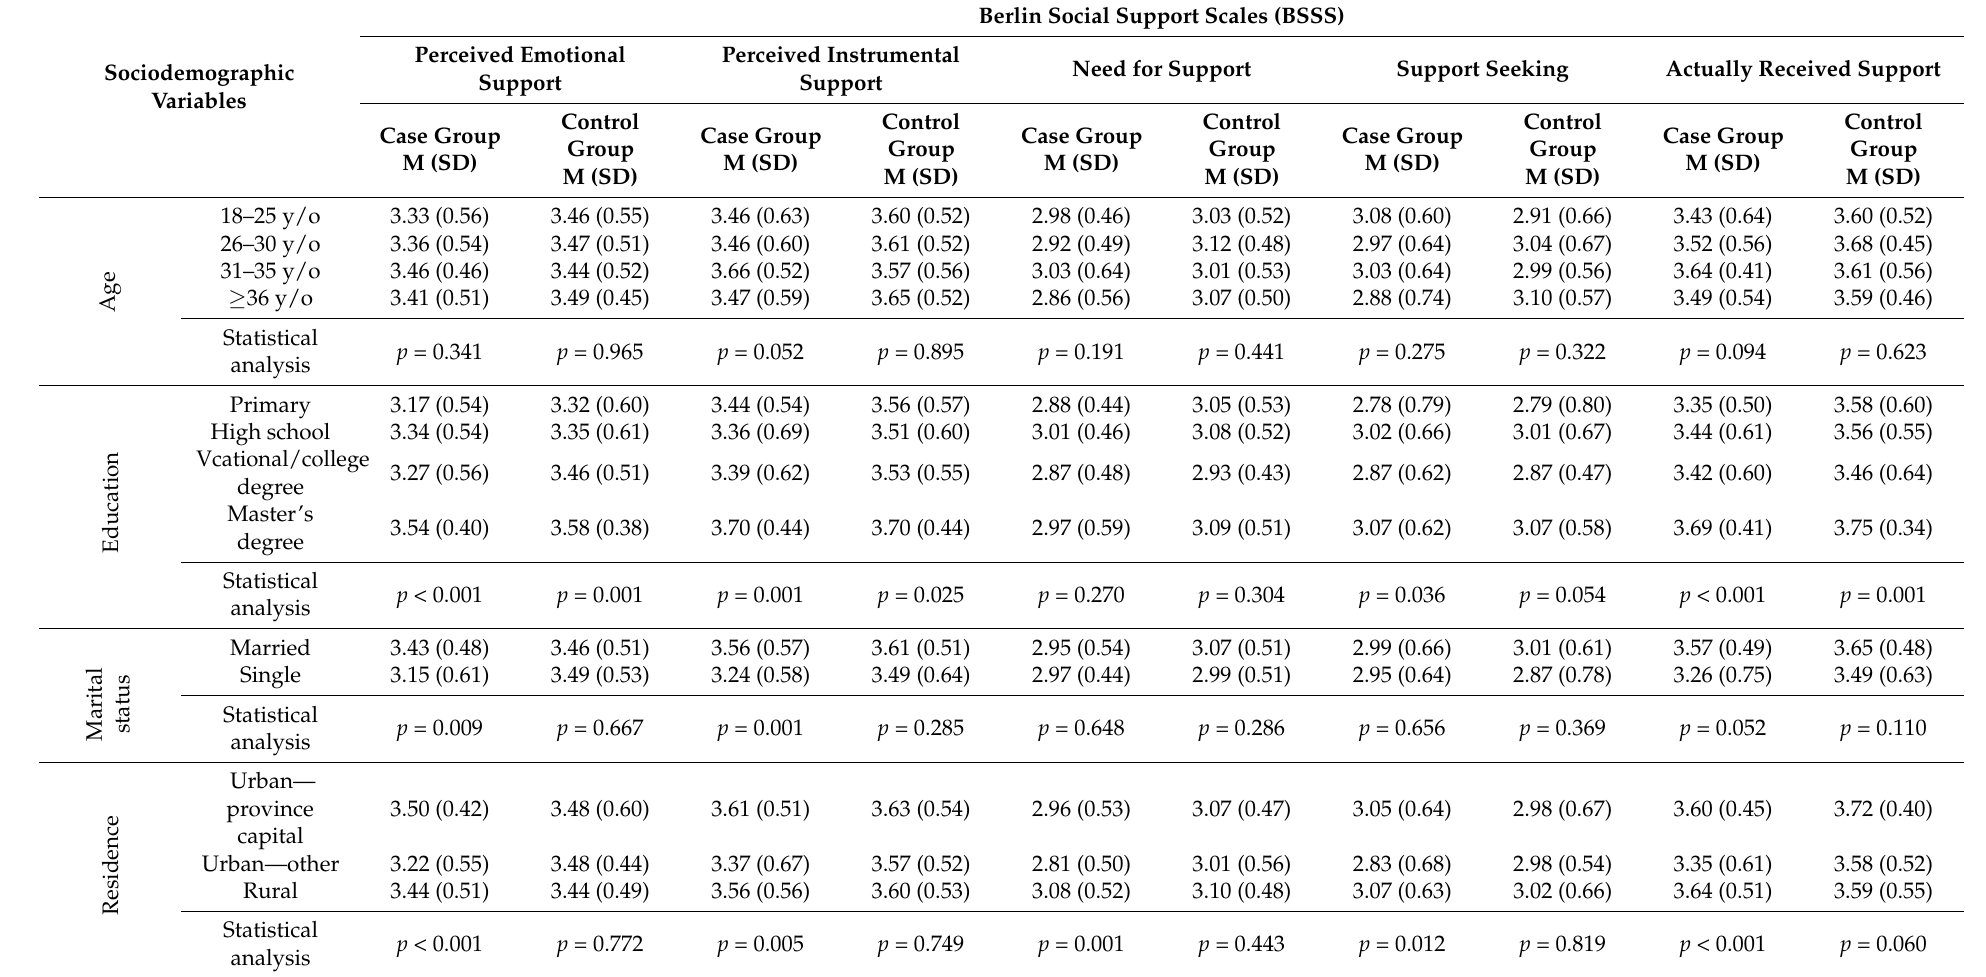
Table 3. The analysis of the relationship between social support and sociodemographic variables among pregnant